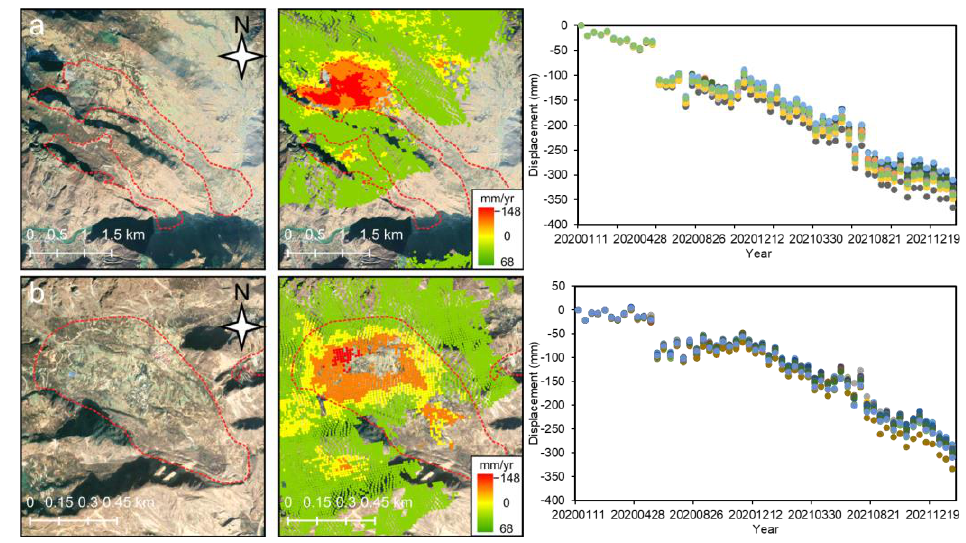
Figure 16. Landslides in high-hazard areas: the ( a ) Suoertou landslide and ( b ) Zhongpaicun landslide.